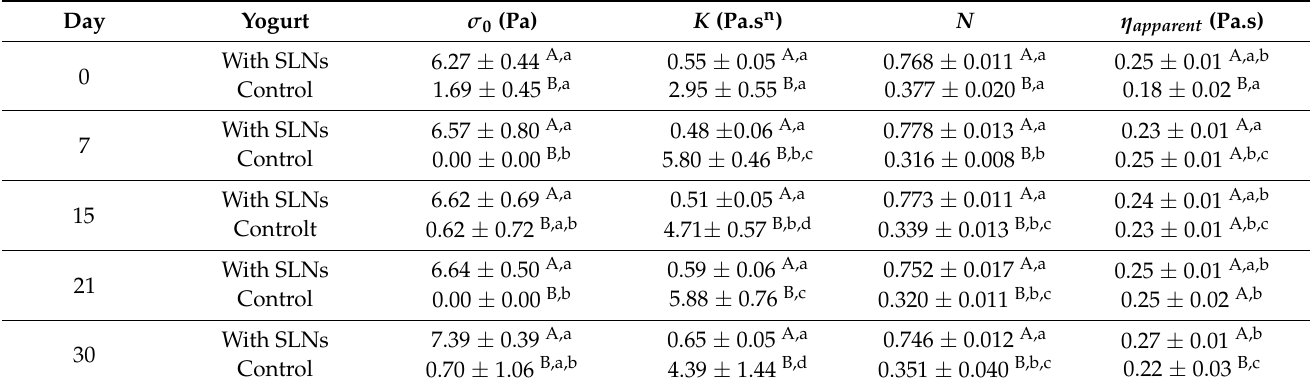
Figure 5. Flow curves of yogurt with SLNs ( a ) and control yogurt (i.e., plain yogurt) ( b ) during shelf-life. Table 1. Rheological properties of yogurt with SLNs and control yogurt (i.e., plain yogurt) during the shelf-life: σ 0 (yield stress), K (consistency index) and n (flow behavior index) fitted with the Herschel-Bulkley model and η apparent (apparent viscosity) at a shear rate of 100 s − 1 .